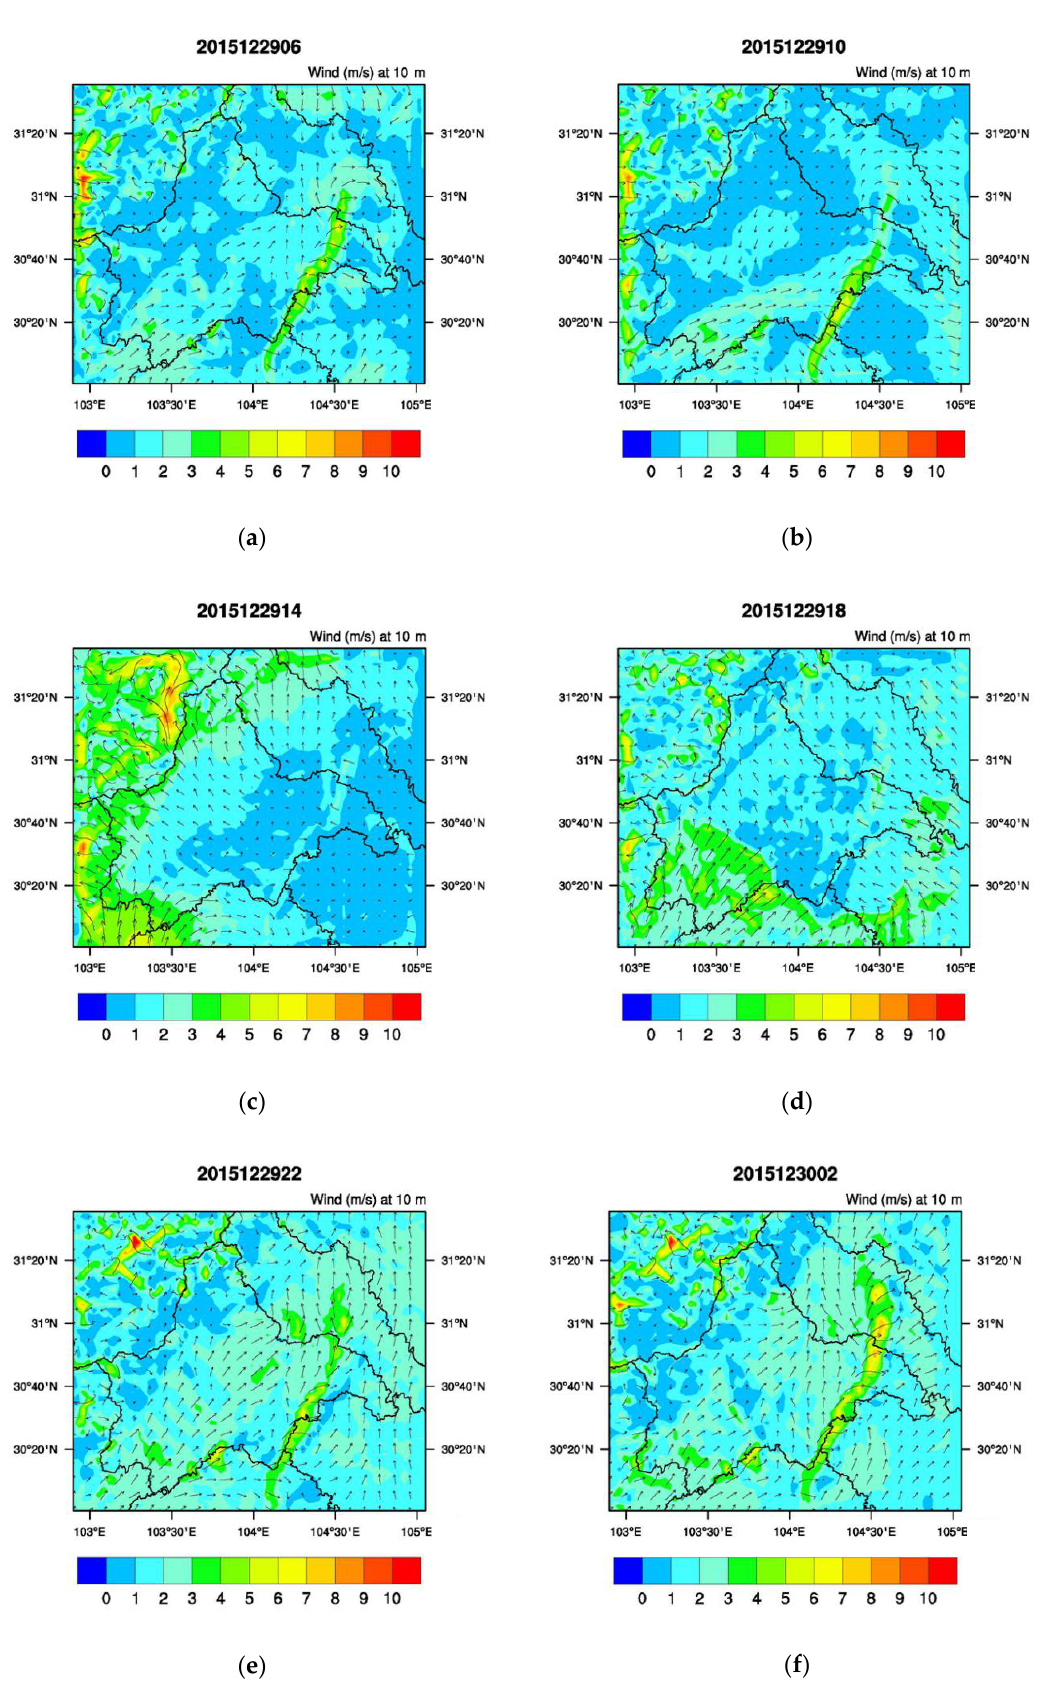
Figure 8. The wind speed map using 2015 land-use data ( a – f ): local time from 06:00 on 29 December 2015 to 02:00 on 30 December